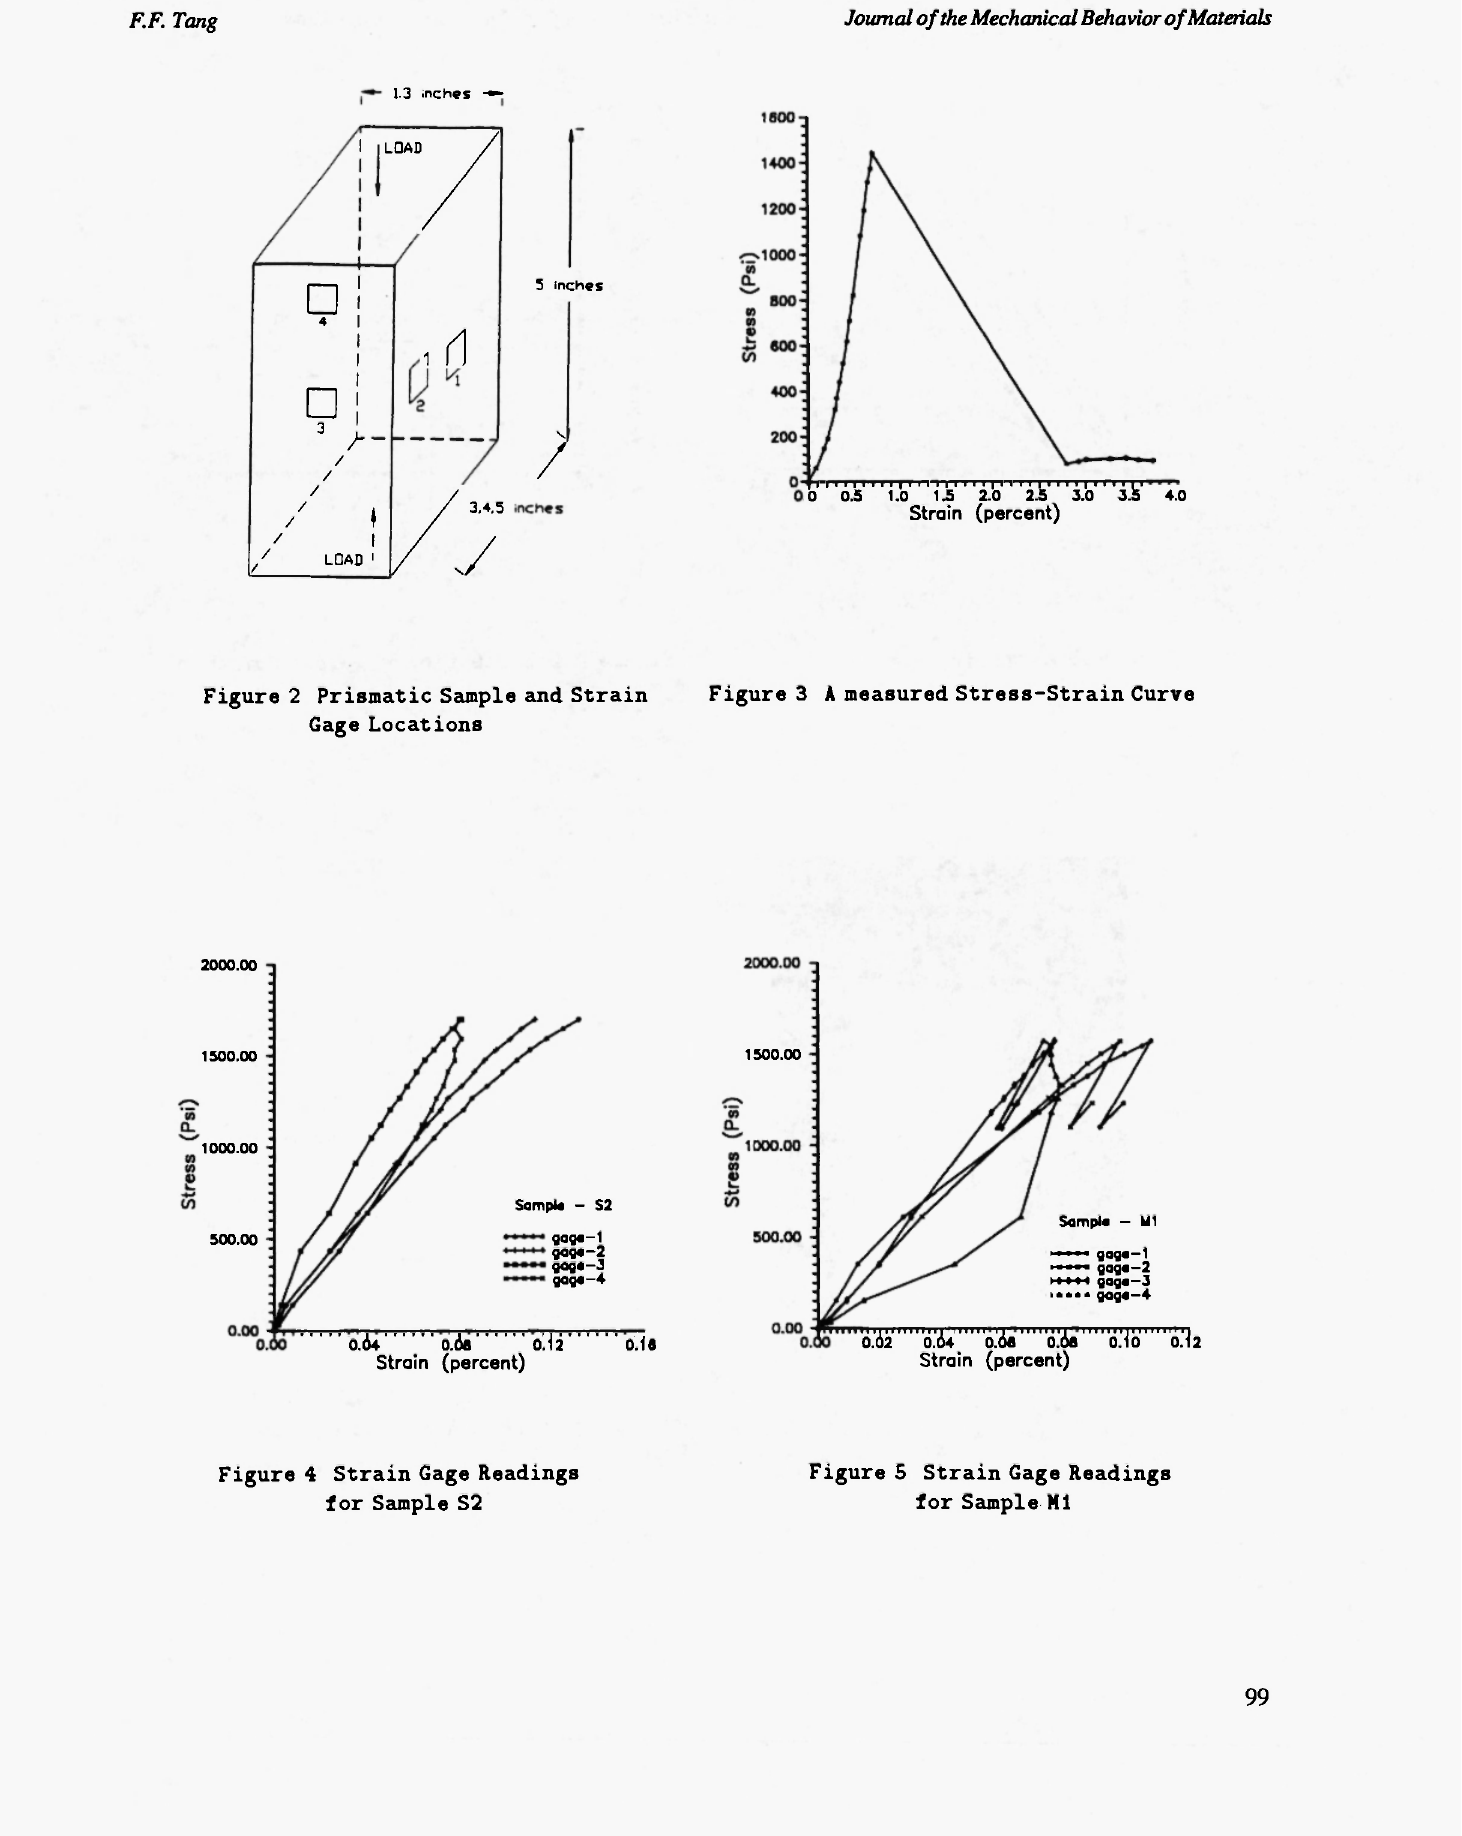
Figure 4 Strain Gage Readings for Sample S2